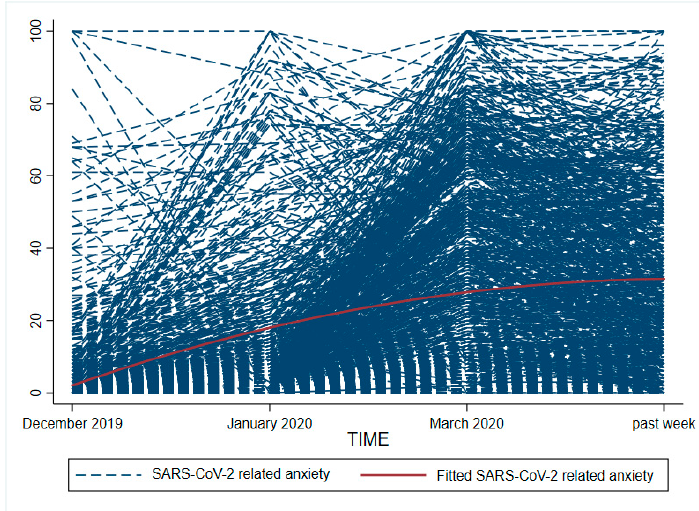
Figure 1. Course of anxiety in relation to SARS-CoV-2 (including COVID-19) on individual level during the COVID-19 pandemic (December 2019, January 2020 and March 2020 retrospectively assessed) (fitted trajectory of sample development added).